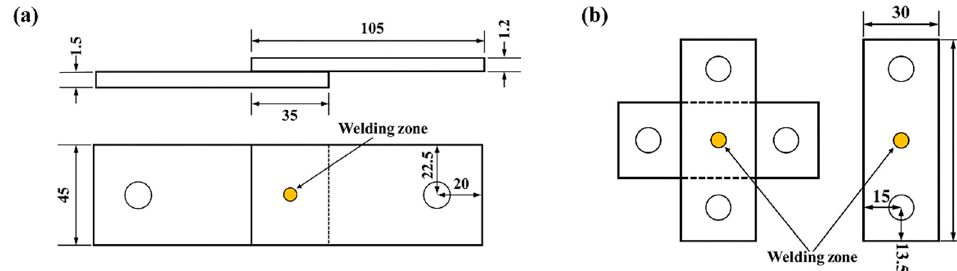
Figure 2. Geometries of the specimens: ( a ) tensile shear specimen; ( b ) cross-tensile